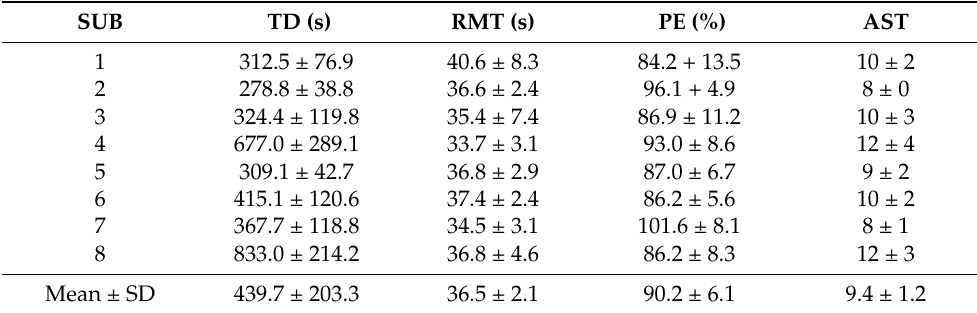
Table 1. Overall performance for successful